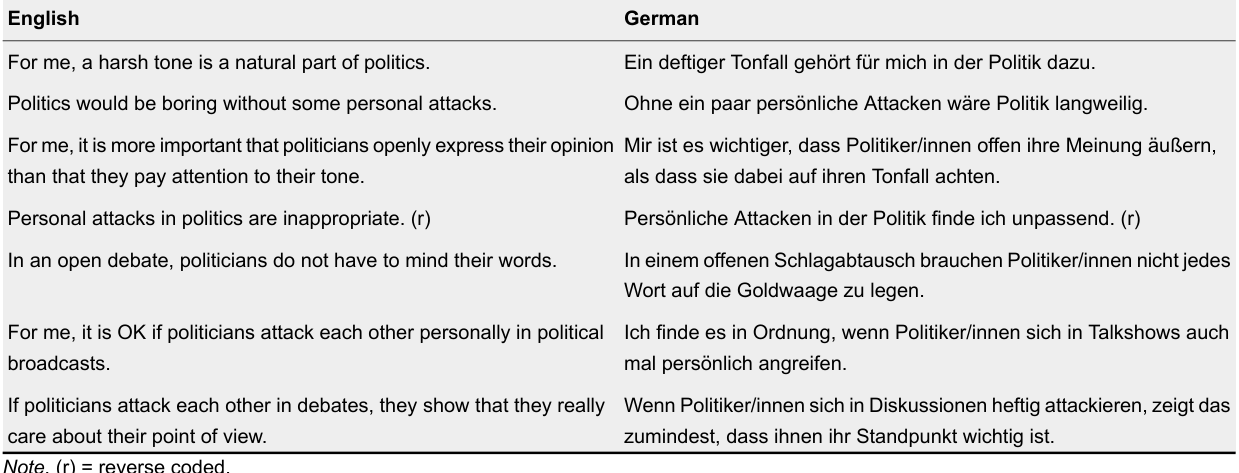
Scale “Attitude Towards Disrespect in Politics”